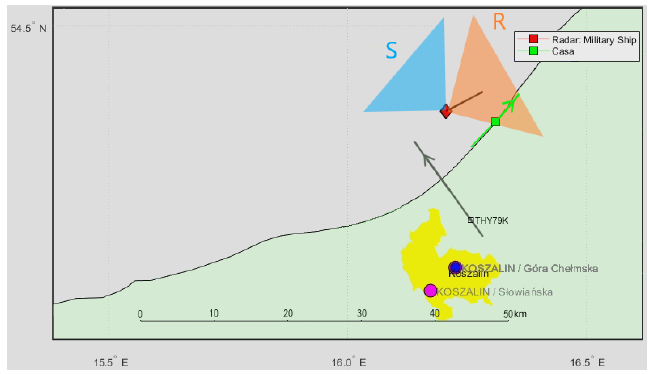
Figure 24. Situation map for THY79K airplane (Boeing Dreamliner) and CASA C-295.